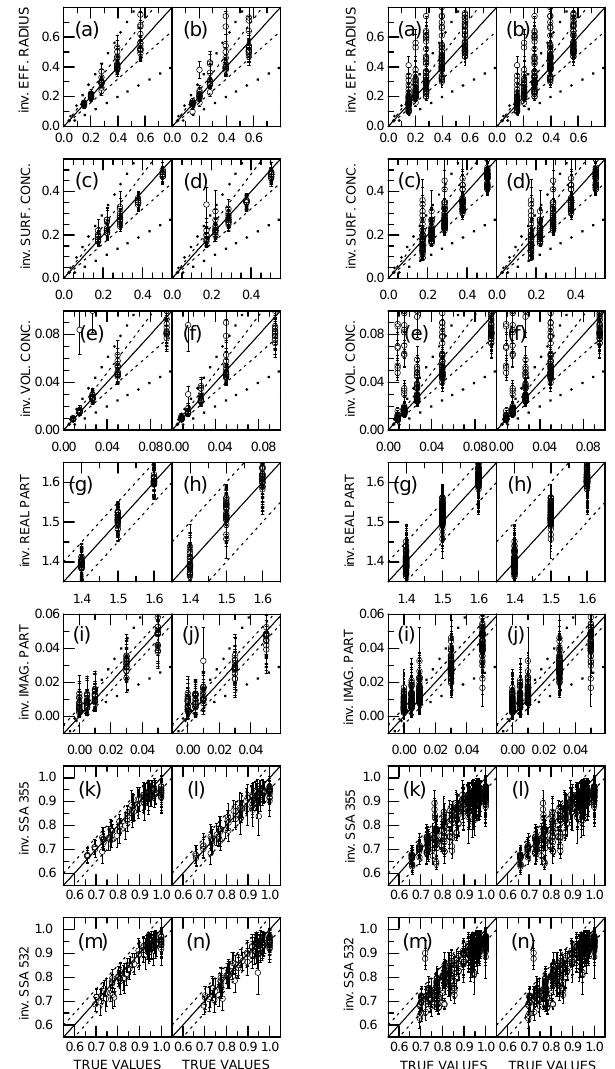
Figure 6. Left panels: TROPOS/UH algorithm results for (a, b) ef- fective radius, (c, d) surface area concentration, (e, f) volume con- centration, (g, h) real part and (i, j) imaginary part of the complex refractive index, and single-scattering albedo at (k, l) 355nm and (m, n) 532nm. Right panels: retrieval results for the case of 15% data uncertainty. The left (right) column in each of the two panels shows the results if the real part is known to an accuracy of 0.05 (0.1). The error bars denote 1 standard deviation. The 1 − 1 lines are shown. The lines for ± 20% deviation from the true results (dashed lines) and for ± 50% deviation (dotted lines) are shown for effective radius, and surface area and volume concentration. In the case of the real part, the dashed lines indicate ± 0.05 deviation (left column in both panels) and ± 0.1 deviation (right column in both two panels). In the case of the imaginary part, the dashed (dotted) lines indi- cate a deviation of ± 0.005 ( ± 50%). In the case of single-scattering albedo the dashed lines show a deviation of ±